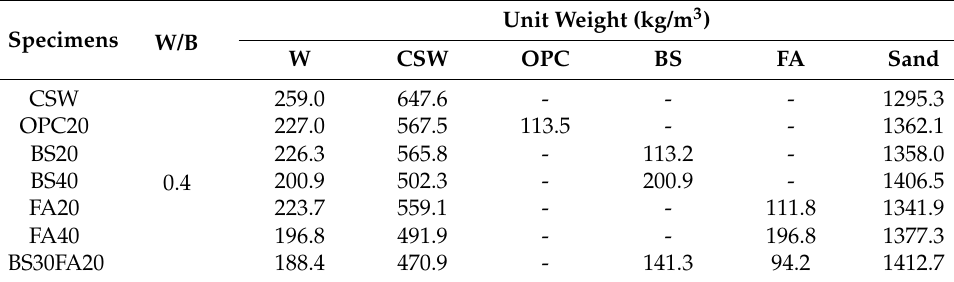
Table 6. Mixture proportion—mortar 1:2.